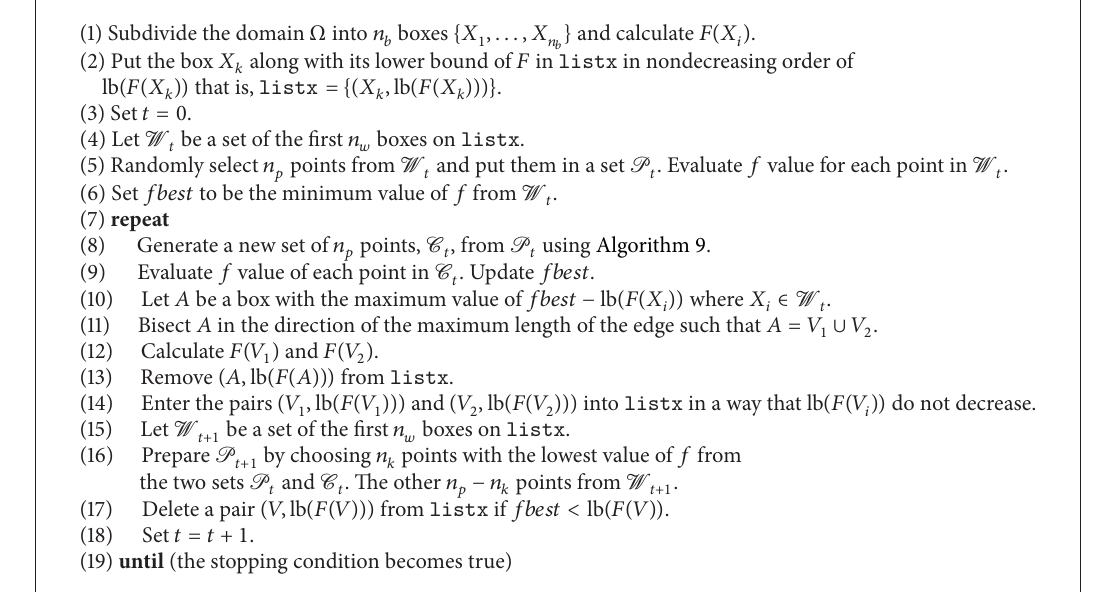
Algorithm 8: Integrated interval algorithm and GA for unconstrained problem.